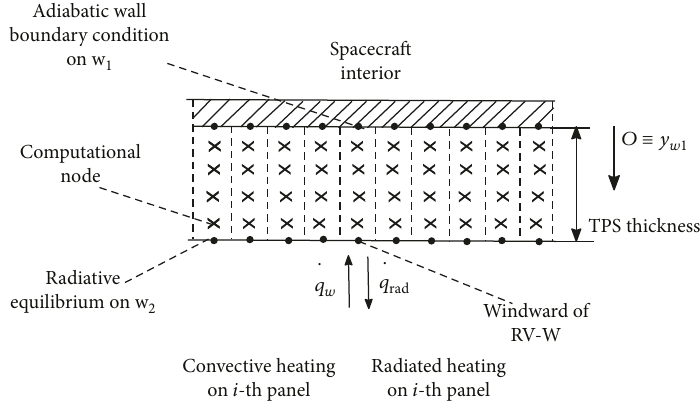
Figure 7: One-dimensional discretization of TPS thickness.